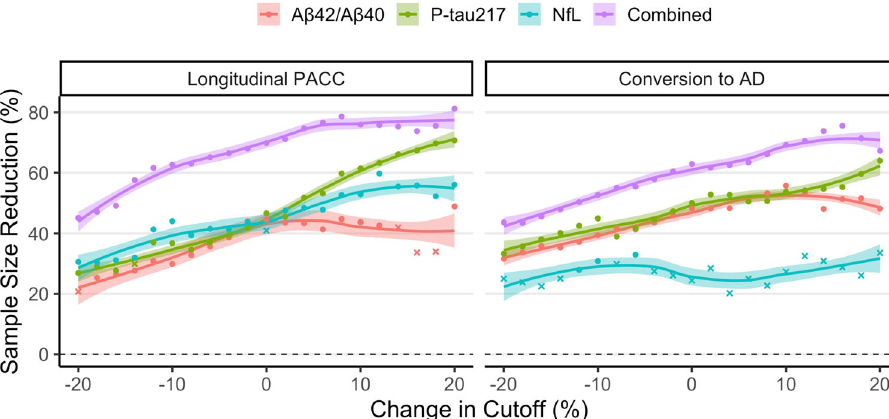
Fig. 4 Effect of inclusion threshold variability on biomarker effectiveness. This fi gure shows the effect that varying the inclusion threshold by 20% in either direction of the pre-de fi ned cutoffs has on the reduction in sample size in a theoretical clinical trial using biomarkers for inclusion enrichment. The reduction in sample size is compared to an unenriched trial with PACC or conversion to AD dementia as primary outcome. For datapoints in the fi gure, “ circles ” represent cutoffs for which the required sample size was signi fi cantly reduced, while “ crosses ” represent cutoffs for which required sample size was not signi fi cantly reduced. Shaded areas represent 95% con fi dence intervals of the loess regression lines fi t over the entire data